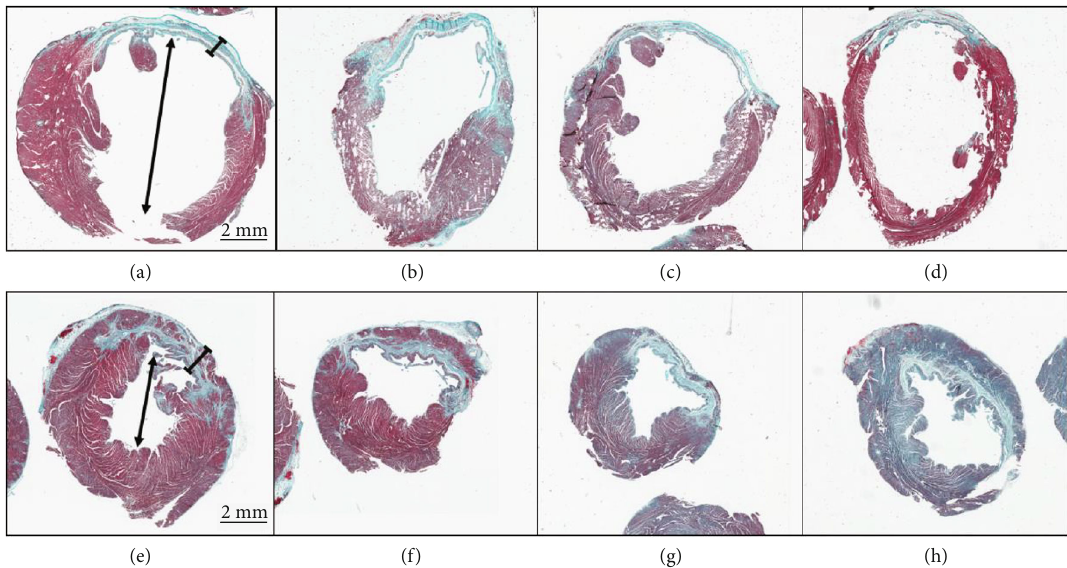
Figure 3: Cardiac histopathology. Representative left ventricular histopathology sections from 4 unique CHF rats (panels a – d) and 4 unique graft-treated rats (panels e – h). Masson ’ s Trichrome stain was performed on 5 μ m transverse sections at the level of the papillary muscles. Micrographs (0.6x) have a 2 mm scale bar for reference. CHF rats exhibit large transmural scars in addition to dilated ventricular cavities, as anticipated with the adverse remodeling from heart failure. Graft-treated hearts exhibit increased wall thickness and increased myocyte density in the previously infarcted region. They also exhibit smaller ventricular cavities compared to the CHF controls.